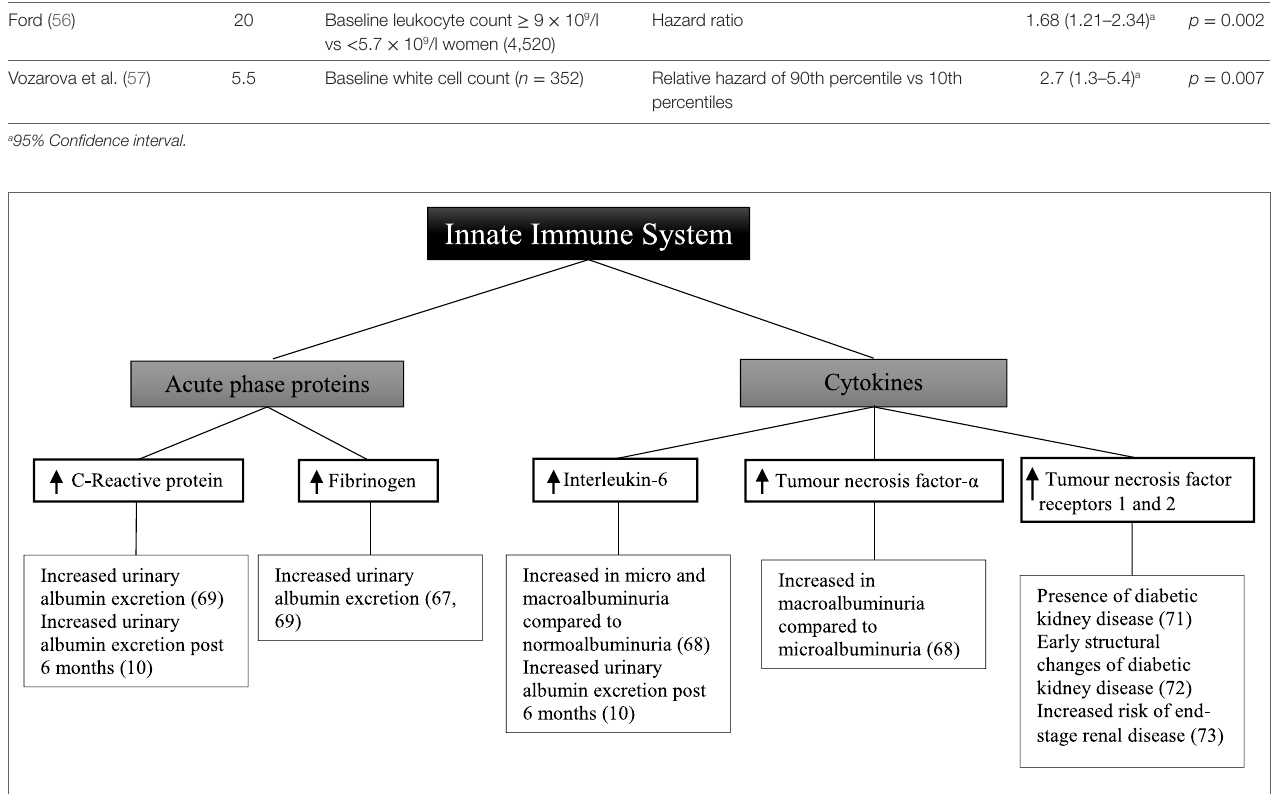
FiGURe 2 | Inflammatory components of the innate immune system and diabetic kidney disease in type 2 diabetes.